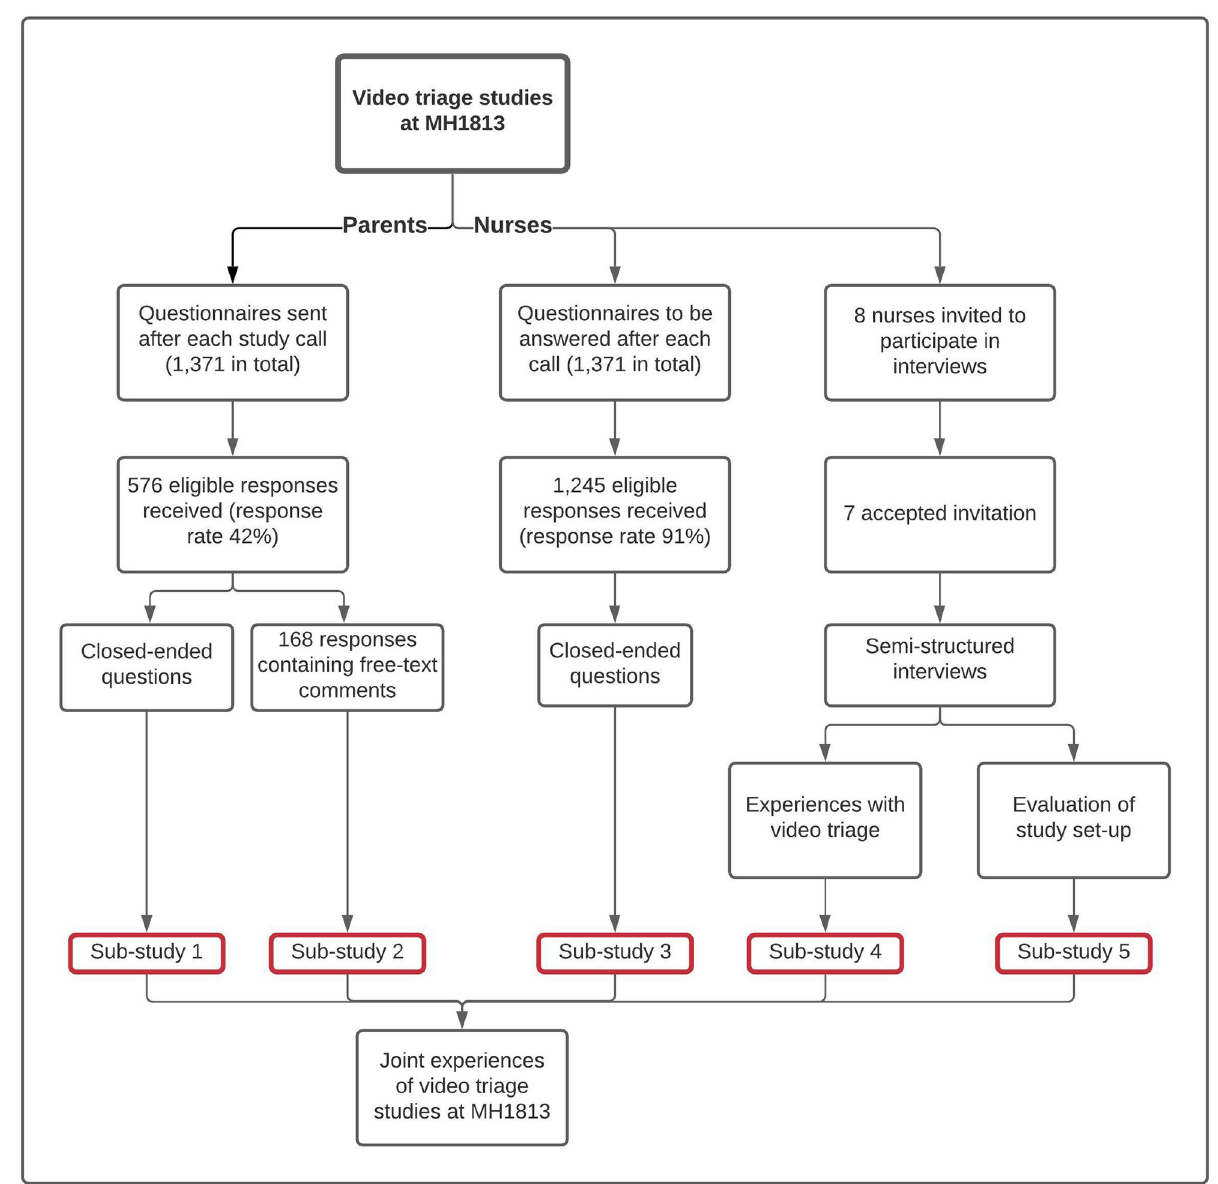
Fig 1. Flowchart of data in the five sub-studies. MH1813: Medical Helpline 1813.